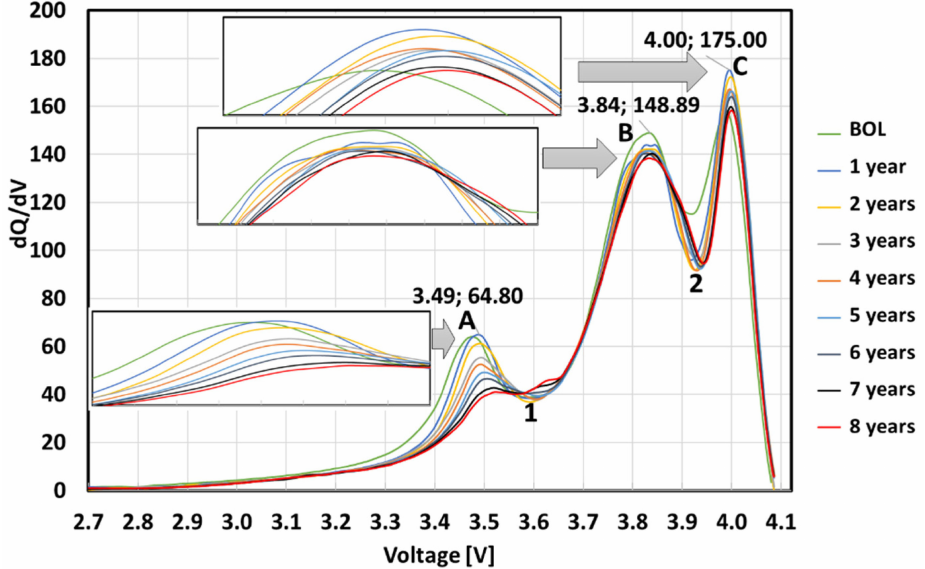
Figure 11. Evolution of IC profiles as the effect of driving cycle